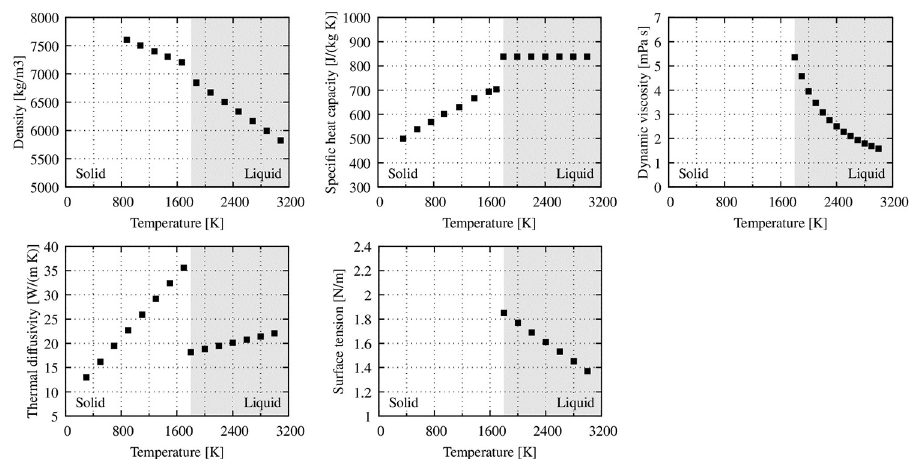
Fig 3. Material properties of solid and liquid stainless steel according to Mills et al. [42]. The grey area indicates the liquid state.